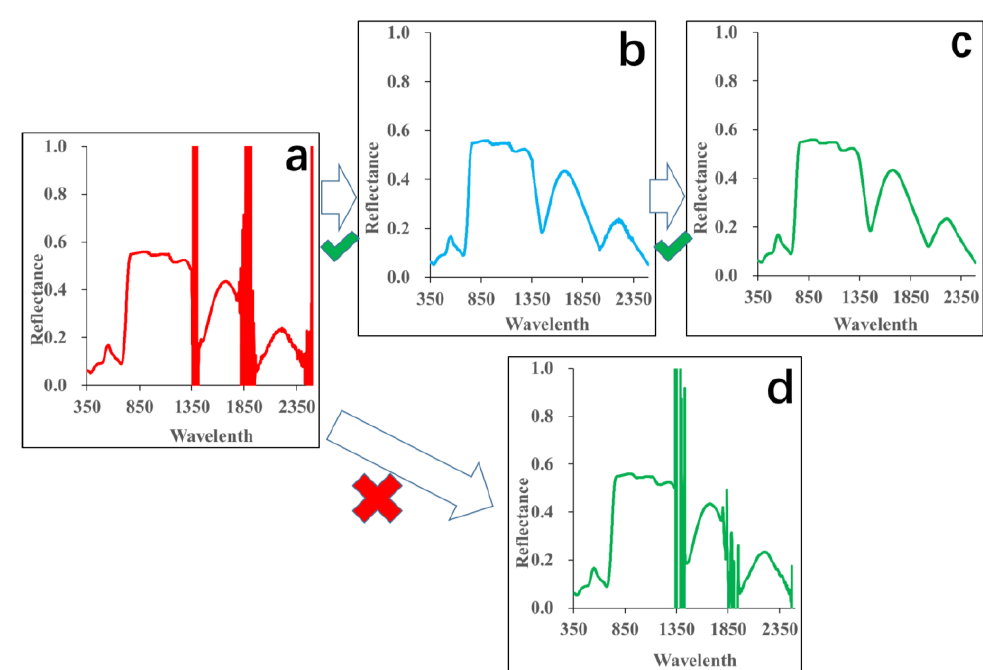
Figure 5. Spectral curves of original data ( a ), linear simulation data ( b ), SG filtering data and ( c , d ) SG filtering data generated by one-step preprocessing. Table 3. Indices selected for this